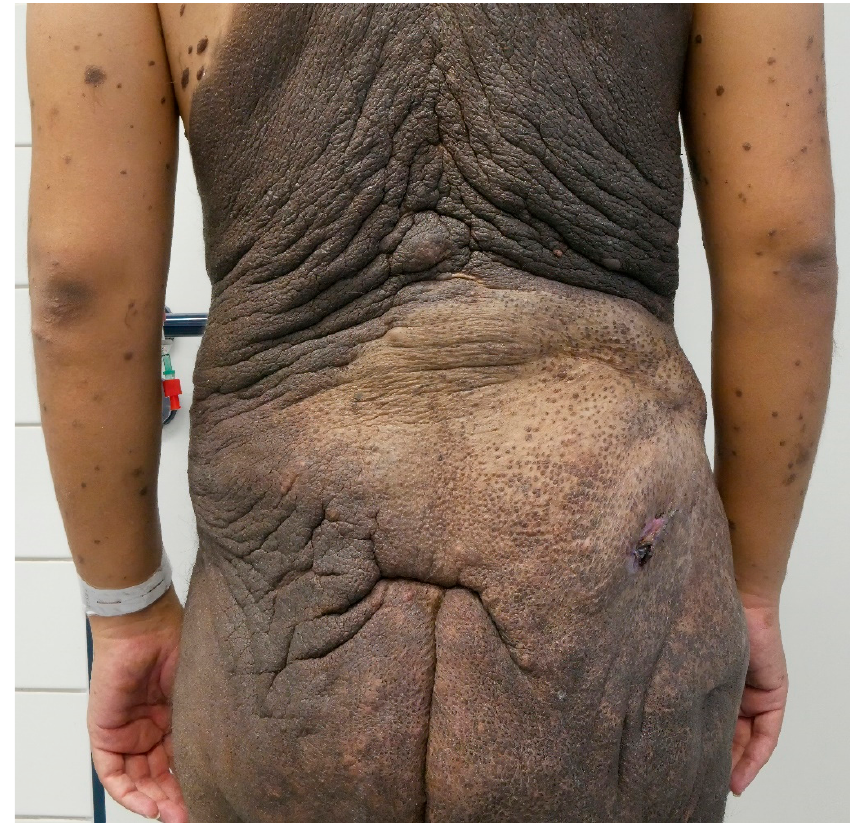
Figure 2. A closer look at a congenital giant melanocytic nevus (bathing trunk subtype) showing huge skin folds with neurofibromatosis-like appearance.